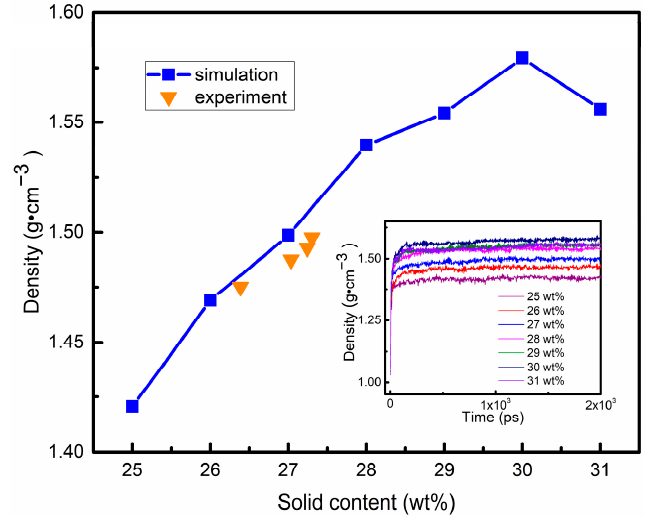
Figure 7. Calculation and experimental density of aluminum sol with different amounts of solid content at 298 k.